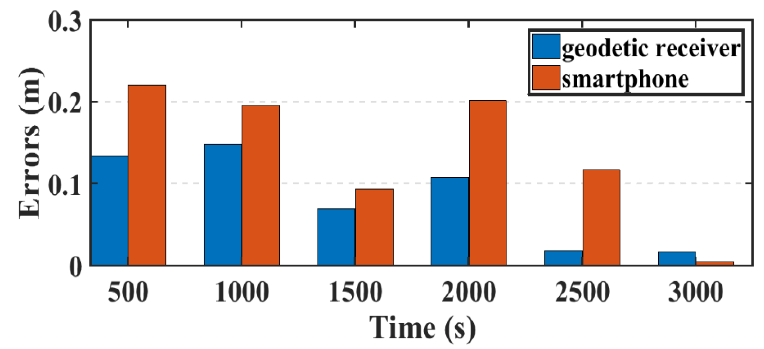
Figure 16. Position errors in Up direction (meters).